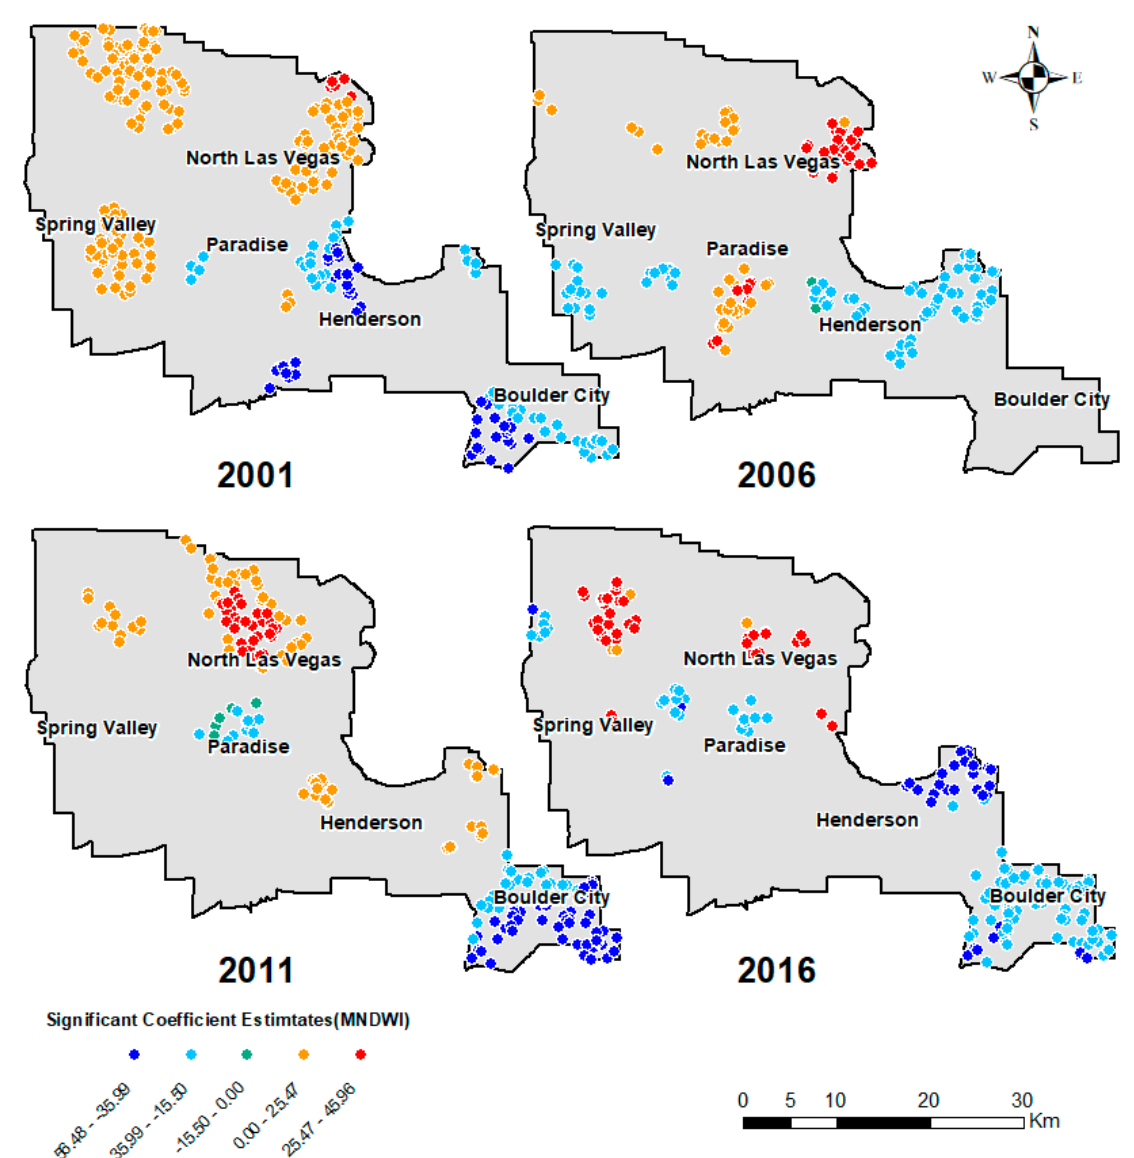
Figure 6. Spatial pattern of the modified normalized difference water index (MNDWI) estimates from the GWR for four years in Las Vegas.